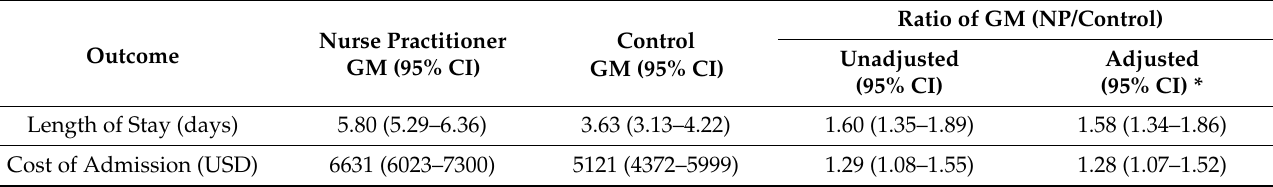
Table 3. Outcomes Measures of Continuous